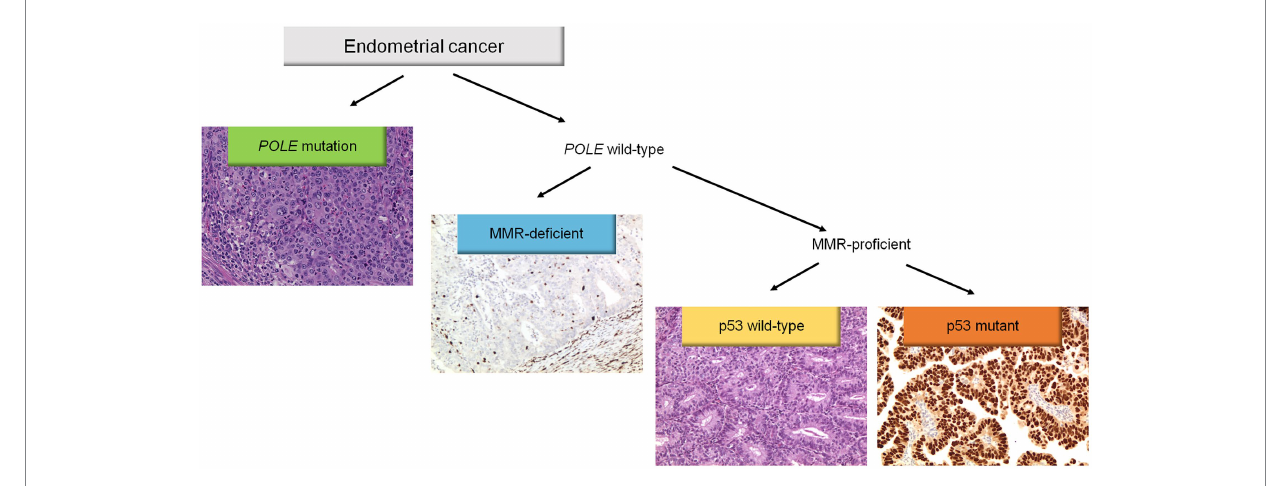
FIGURE 1 Diagnostic algorithm for the integrated histomolecular endometrial carcinoma classification. This algorithm can be applied for all histological endometrial cancer histotypes (including